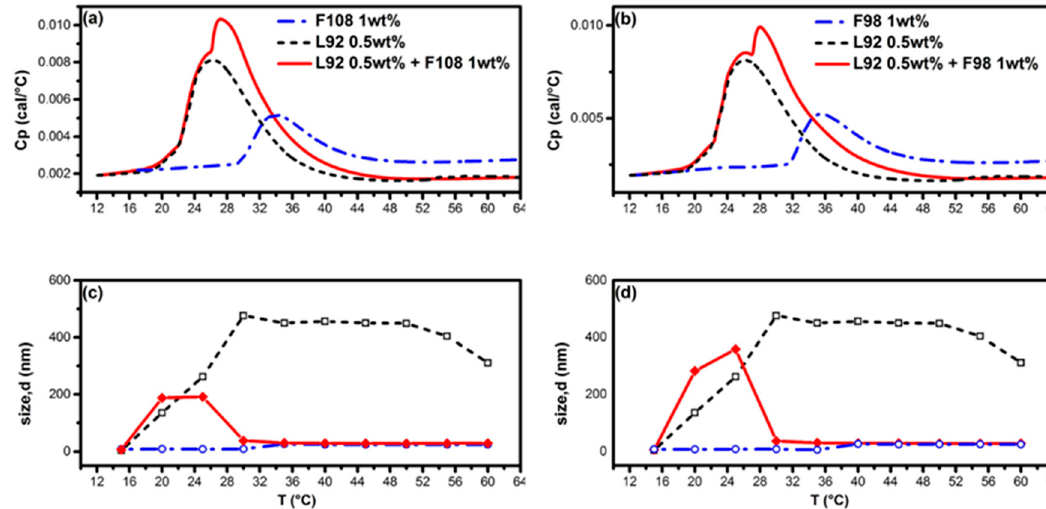
Figure 3. HSDSC thermograms ( a , b ) and evolution of size of aggregates ( c , d ) as a function of temperature from DLS; ( a , c ) Mixed Pluronic 0.5 wt % L92 + 1 wt % F108 system; ( b , d ) Mixed Pluronic 0.5 wt % L92 + 1 wt % F98 system. Red solid line and diamond ( ◆ ) for mixed Pluronic system. Black dashed line and open square ( □ ) for L92. Blue dashed-dotted line and open circle ( ○ ) for F108/F98. Instead of F108, a slightly shorter PPO block length of F98 (with 45 PO units) was applied to examine the self-assembly process of the mixed Pluronic 0.5 wt % L92 + 1.0 wt % F98 system. Figure